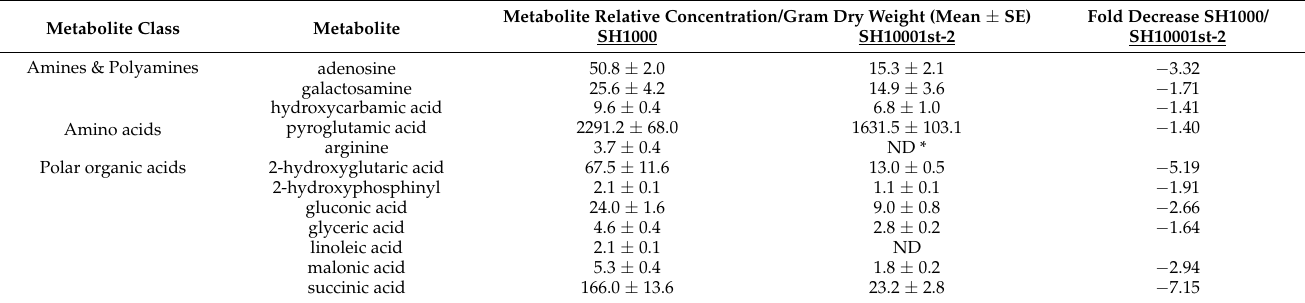
Table 7. Metabolites decreased ( p ≤ 0.05) in SH10001st-2 compared to